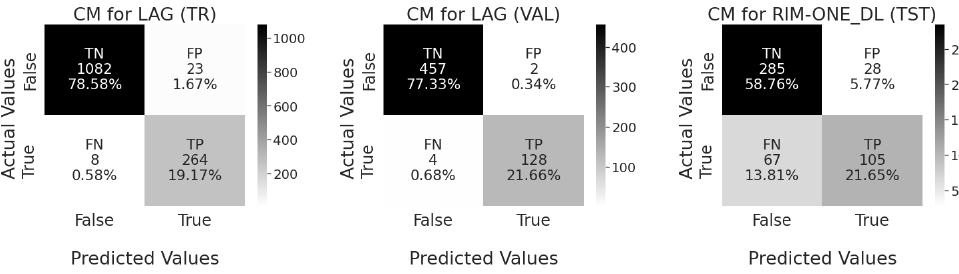
Figure 6. Confusion matrix of ResNet-50 trained parameters for GON-OD.